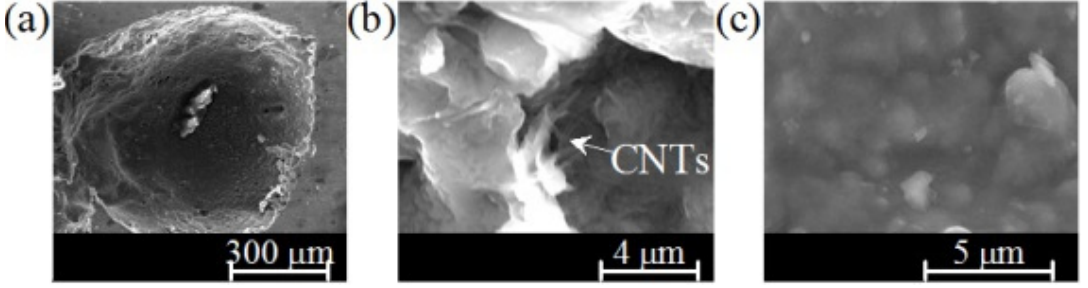
Figure 10. Cellular-pore ( a ) and magnified images of its pore-wall microstructure with ( b ) and without Figure 10. Cellular ‐ pore ( a ) and magnified images of its pore ‐ wall microstructure with ( b ) and MWCNTs-COOH dispersed in its aluminum-matrix ( c without MWCNTs ‐ COOH dispersed in its aluminum ‐ matrix ( c ).